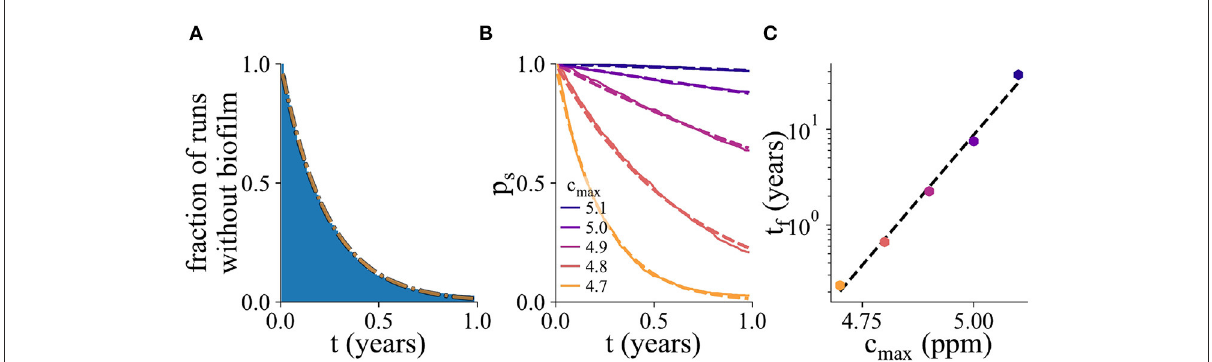
FIGURE5 Probability of biofilm establishment. (A) Normalized histogram (blue) of the number of replicate simulation runs in which biofilm has not yet formed by time t , for 2,000 replicate simulations, for c max 4.7ppm. The fitted exponential probability distribution, p s ( t ), is shown in orange. (B) = The probability distribution p s ( t ), for a range of values of c max . Here, the percentage of resistant microbes is set to 14% for the c max value of 5